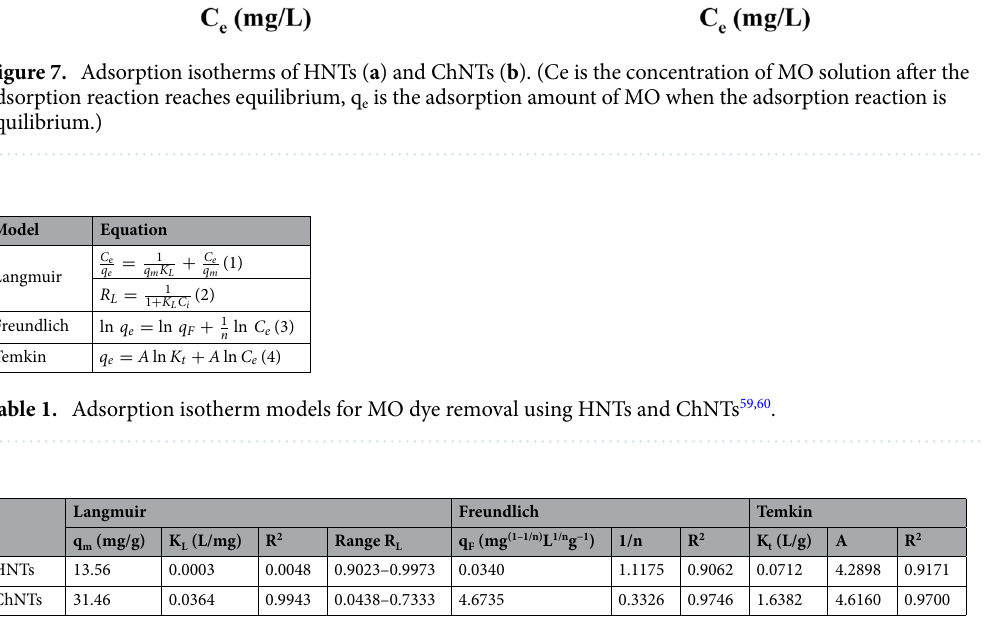
Table 2. Isotherm parameters of HNTs and ChNTs removing